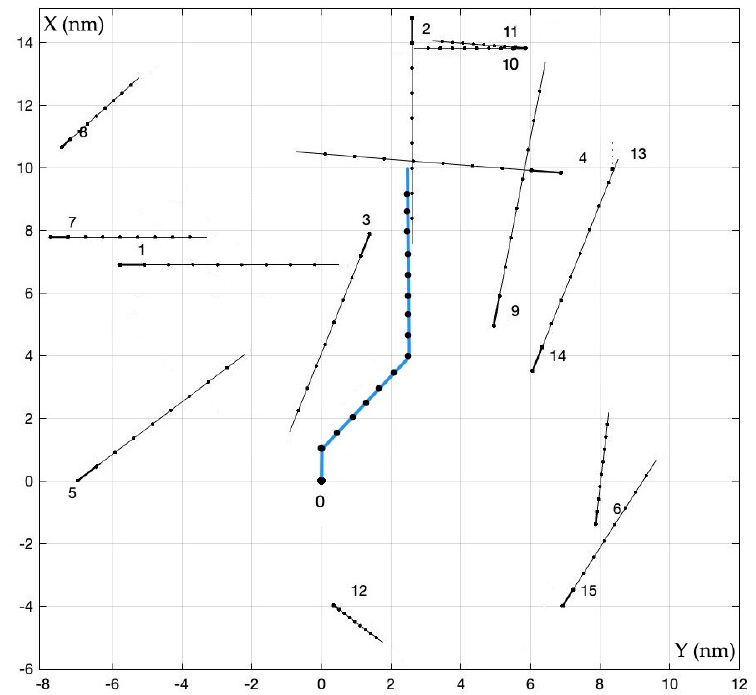
Figure 13. Trajectories of ships in non ‐ game matrix control ANGRC.